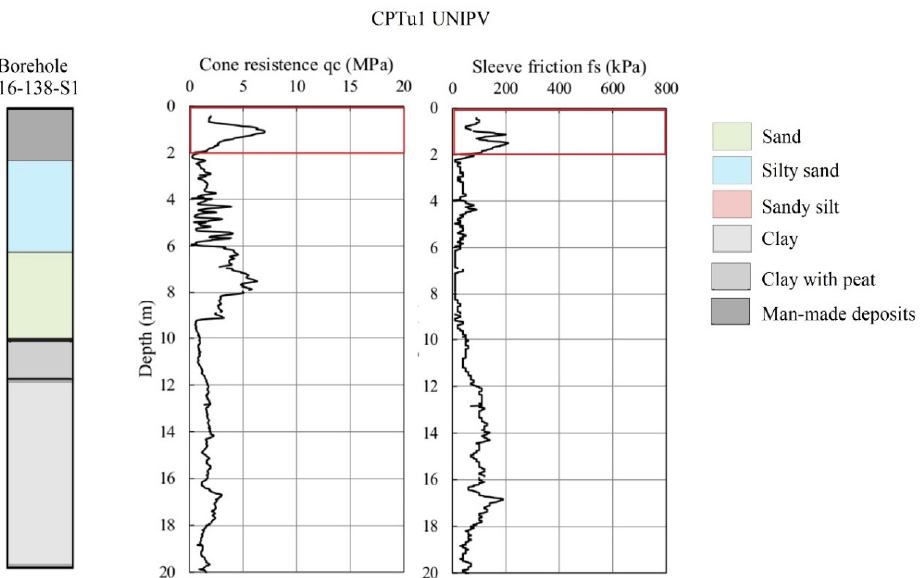
Figure 7. Comparison of a pair of boreholes and CPTu measurements (qc and fs), including the detection of the thickness of the anthropogenic deposits (red box).